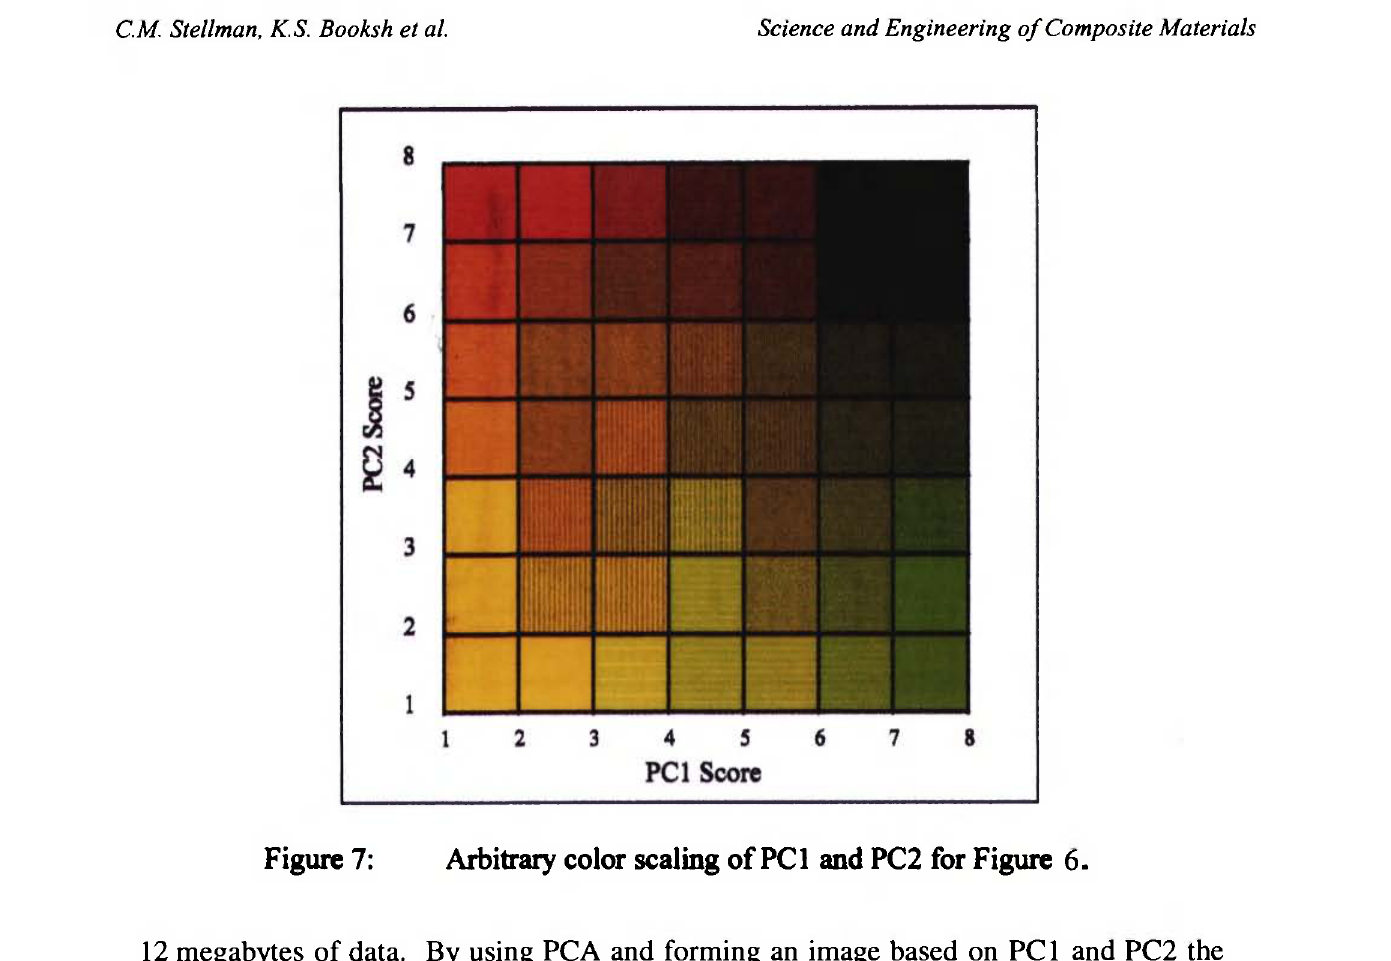
Figure 7: Arbitrary color scaling of PCI and PC2 for Figure 6- 12 megabytes of data. By using PC A and forming an image based on PCI and PC2 the same spectral variance can be described with two images of 12 kilobytes each. Two different data sets were collected for the simulated